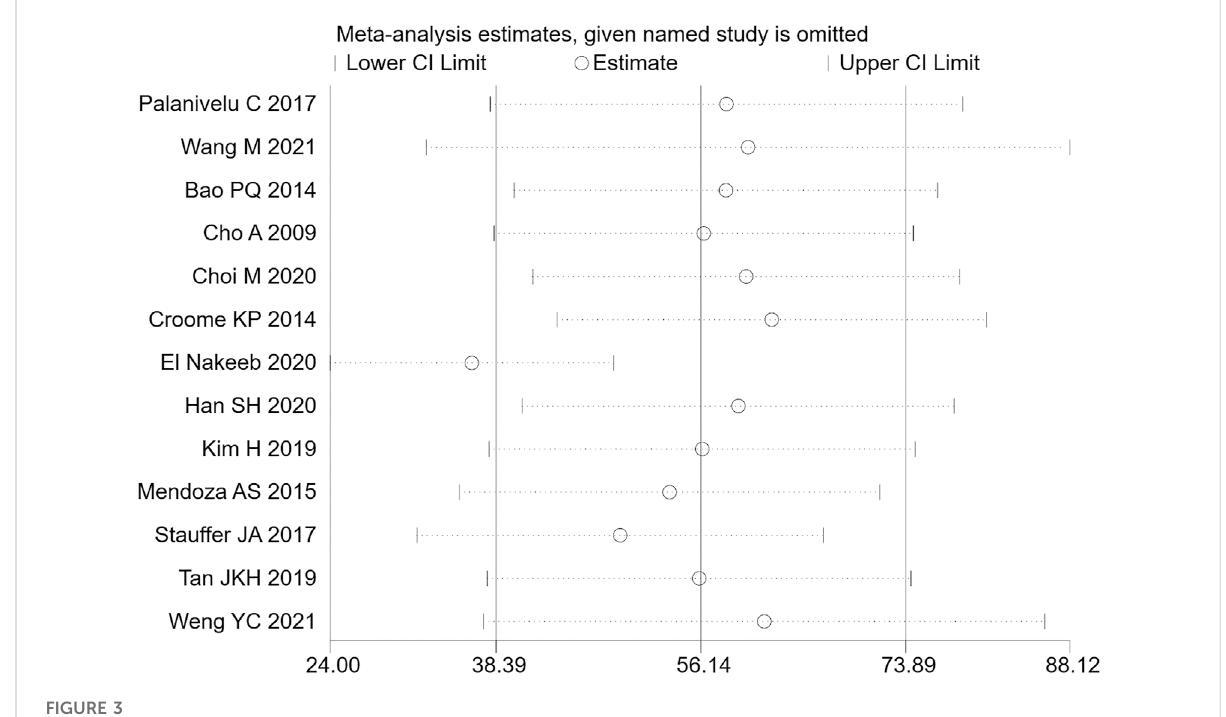
FIGURE 3 Sensitivity analysis of operation time.